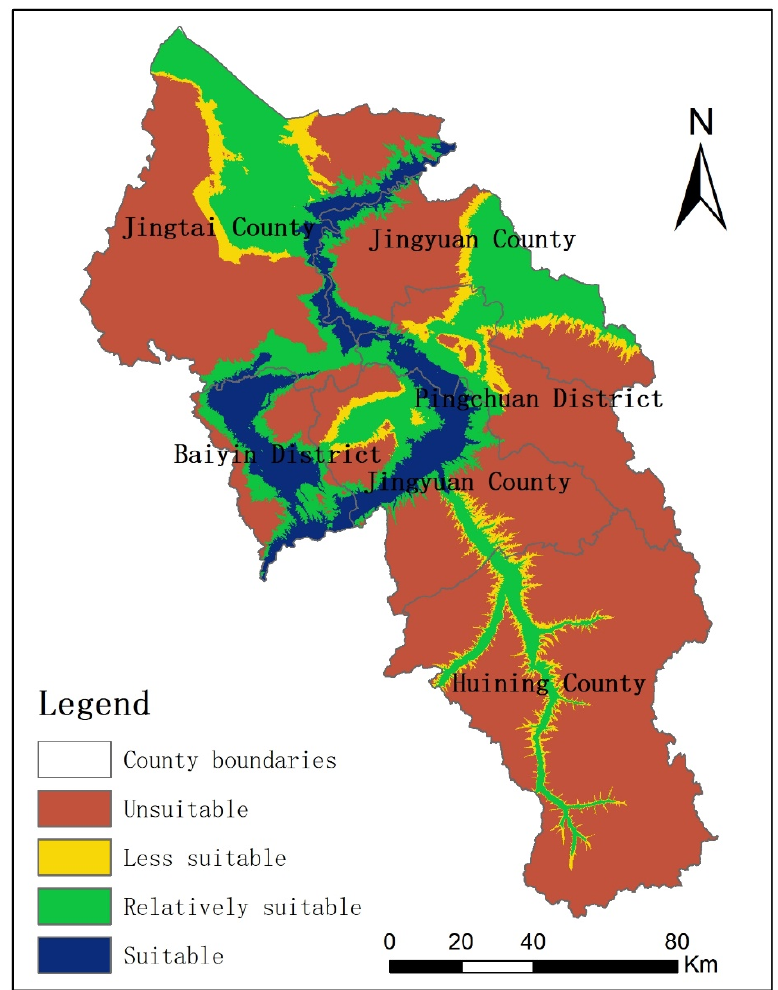
Figure 7. WRSU of Baiyin City.